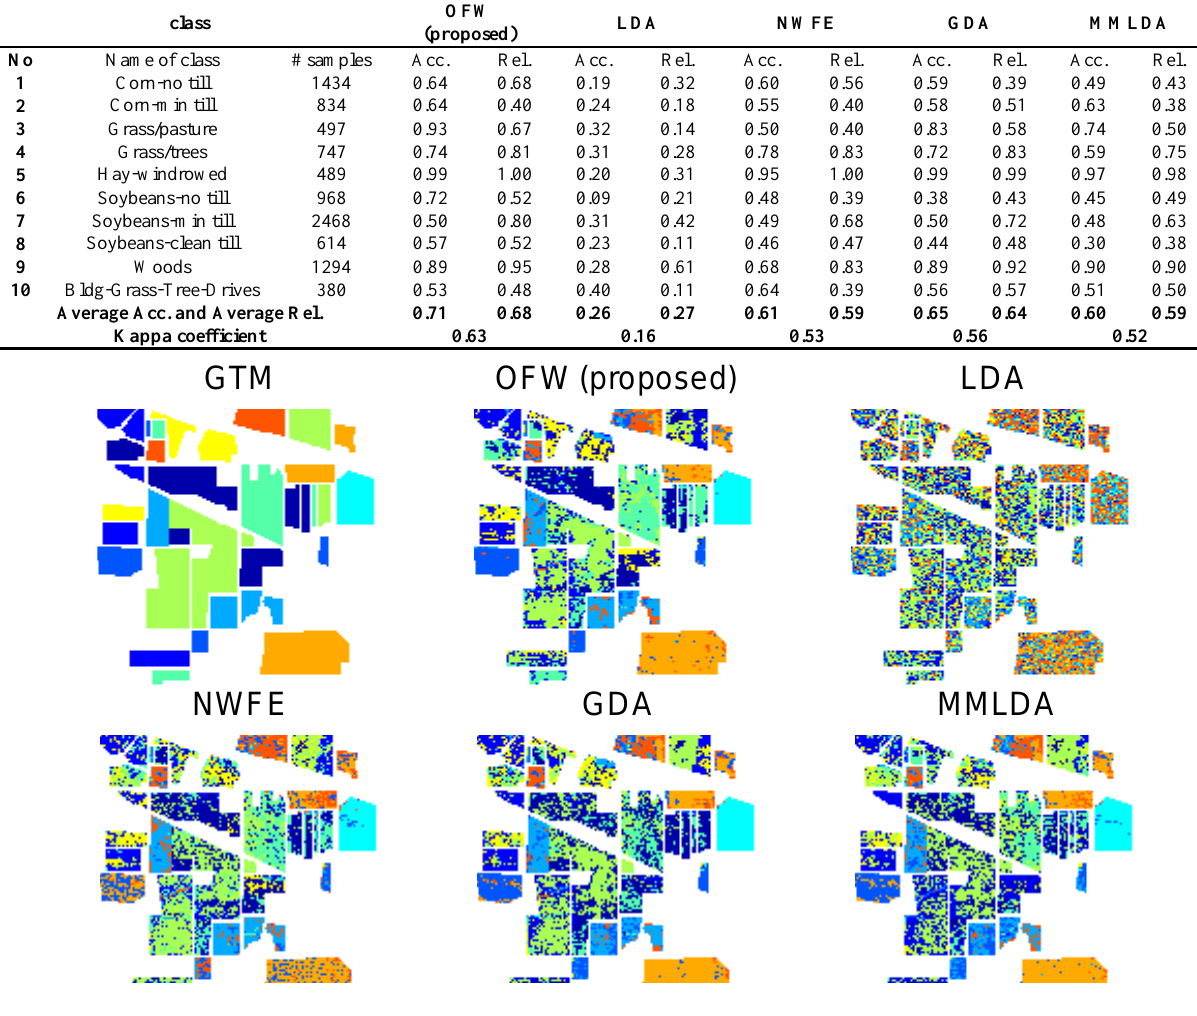
Figure 7. GTM and classification maps for Indian dataset obtained by SVM classifier and 9 extracted